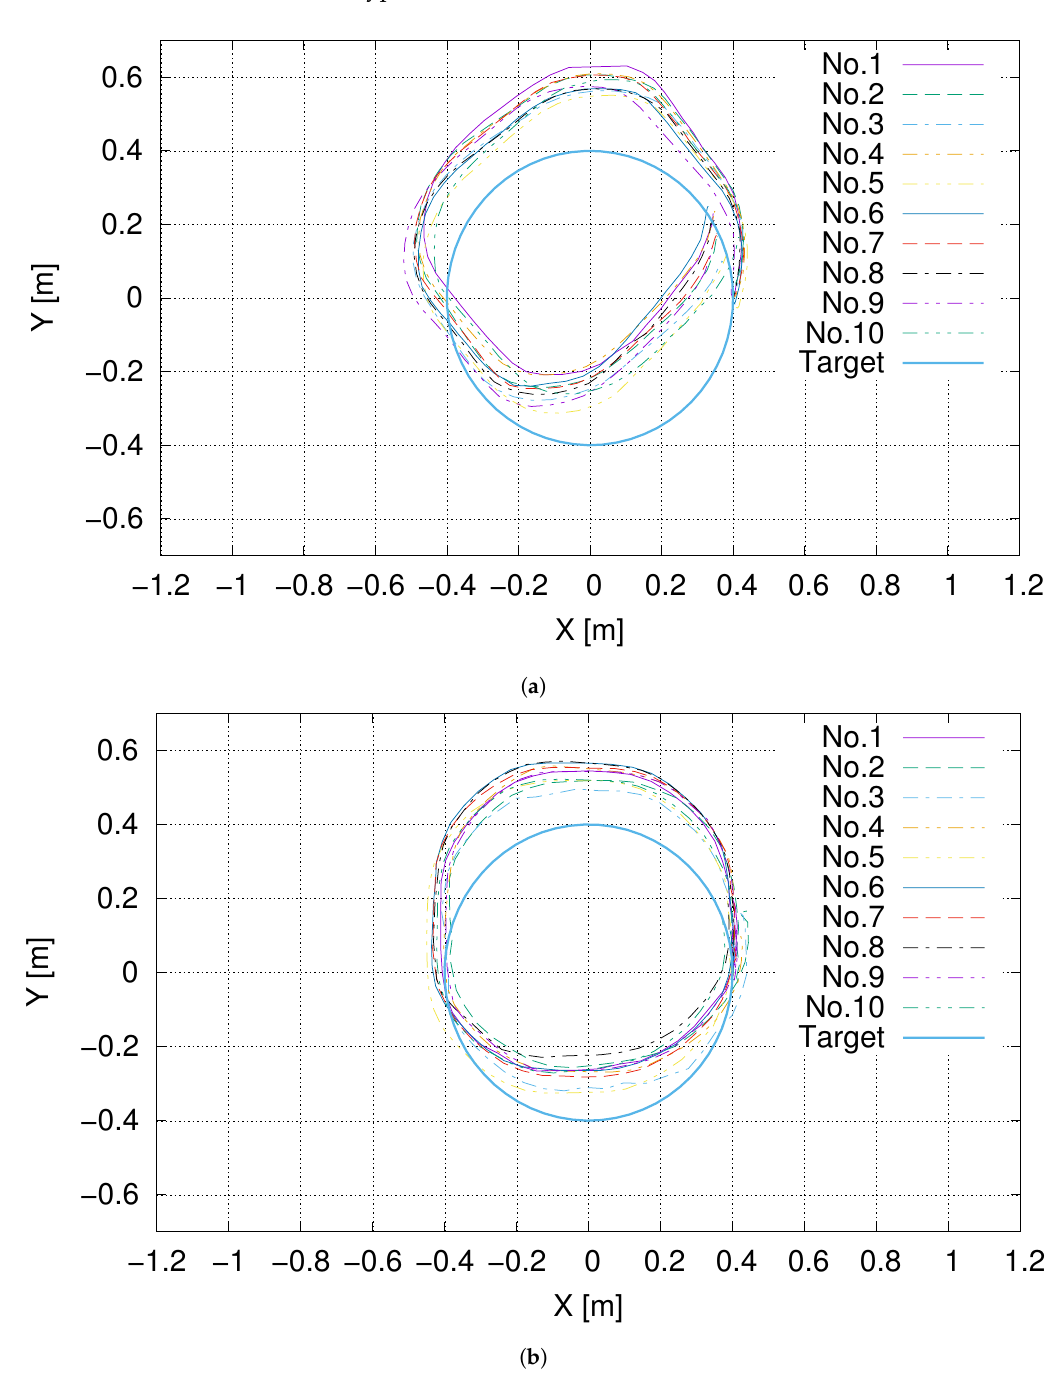
Figure 5. The robot trajectory during each run using circle pattern. ( a ) Conventional robot; ( b ) pro- posed